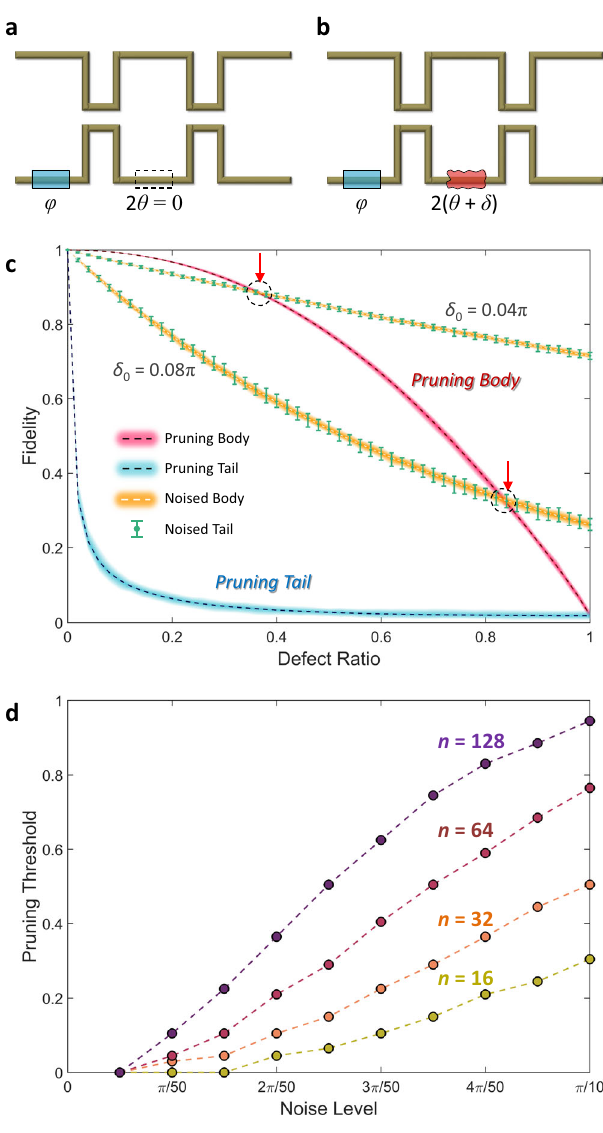
Fig. 3 | Pruning is often better than noise. a The concept of pruning in pro- grammablephotoniccircuits.Thephaseshifter2 θ ofthebuildingblockisreplaced with anordinary waveguide,which preservesthe symmetryinthe MZI arms. b The noisybuilding block.The phaseshifter2 θ isperturbedas2( θ + δ ). c Comparisonof the fi delities of the U 128 photonic circuits in different groups: pruning body (red line), pruning tail (blue line), noisy body (orange line) and noisy tail (green error bars). The thicknesses of the colored lines and the error bars present the range of the fi delities between their maxima and minima. The red arrows indicate the pruning thresholds for each case. Two pairsof groups with noisy bodies and noisy tails are shown for δ 0 =0.04 π and 0.08 π , which correspond to about 2K – 4K tem- perature changes in silicon infrared thermo-optical phase shifters 27 . d Pruning threshold as a function of the noise level δ 0 for different degrees of unitary operators.In( c )and( d ),100random U n realizationsareanalyzedpervalueof n and defect